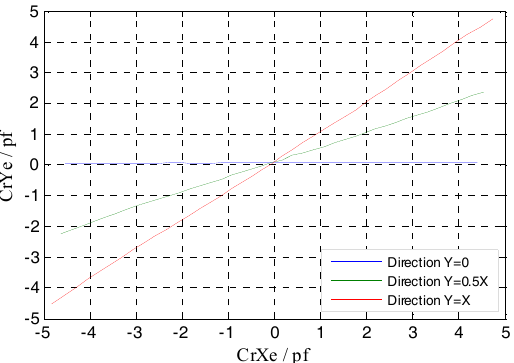
Figure 25. The comprehensive comparison of the curves of CrYe/CrXe in the different radial runout directions.